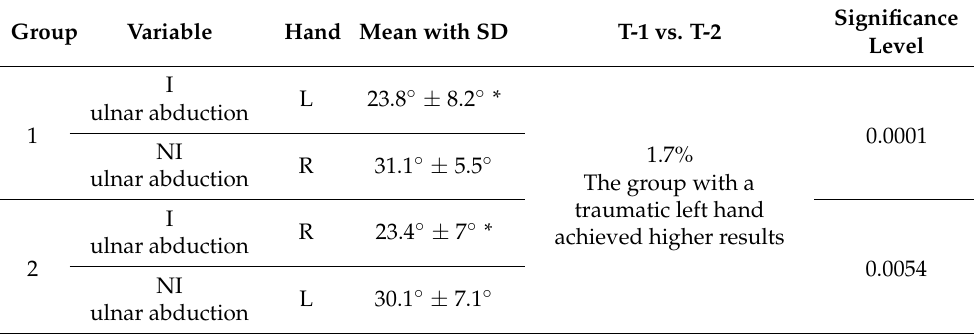
Table 5. Comparison of results for ulnar